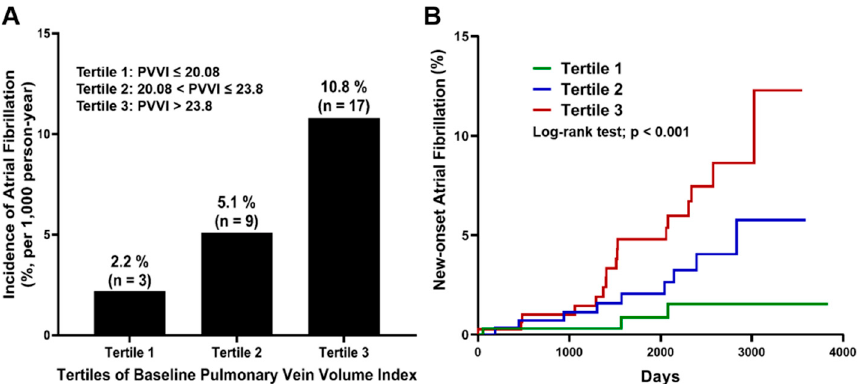
Figure 3. ( A ) Incidence of atrial fibrillation according to the baseline PVVI tertiles. ( B ) Illustration of the cumulative incidence of new-onset AF using the Kaplan-Meyer method. AF = atrial fibrillation, PVVI = pulmonary vein volume index.